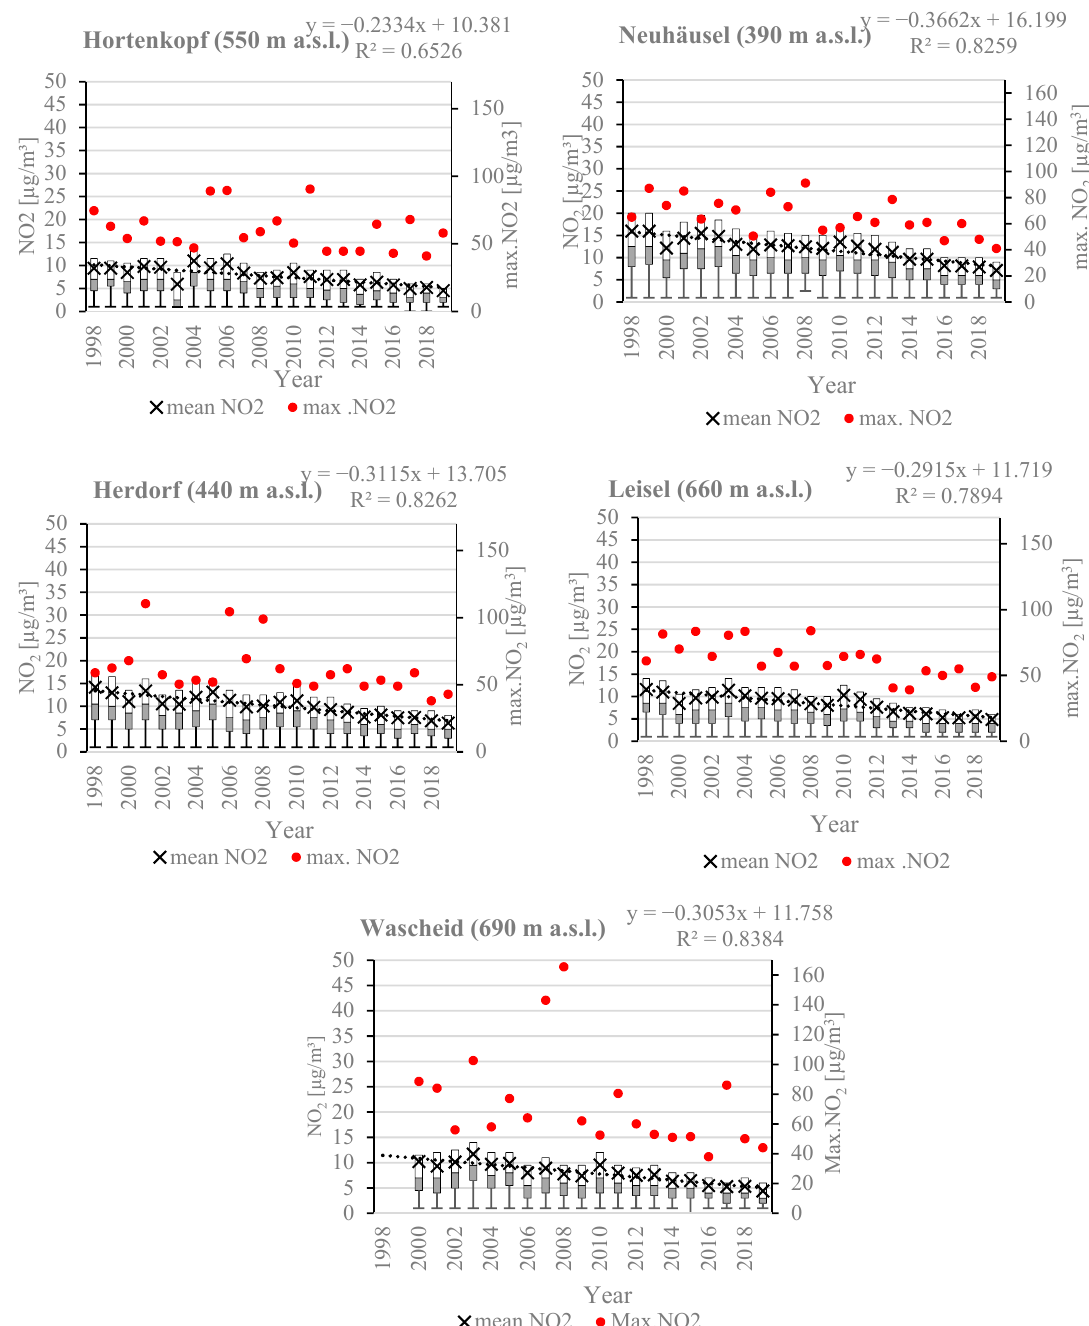
Figure 3. Variance and trends (ranges, quartiles, medians and means) of hourly NO2 concentrations ( µ g / m 3 ) at the sites. The temporal trend is shown as the regression line of annual means for n = 22 years (Wascheid only n = 20) with the regression equation and coe ffi cient of determination. The end of the lower whiskers represent the hourly minimum of the year on the primary y -axis, whereas—unlike in Figure 2—maximum values (4th quartile) are not shown as whiskers, but as points on the secondary y -axis. The line between the first and third quartile characterizes the annual median. The pointed line symbolizes the temporal regression of the annual means over the study period. The significances of the temporal trends are documented in Table